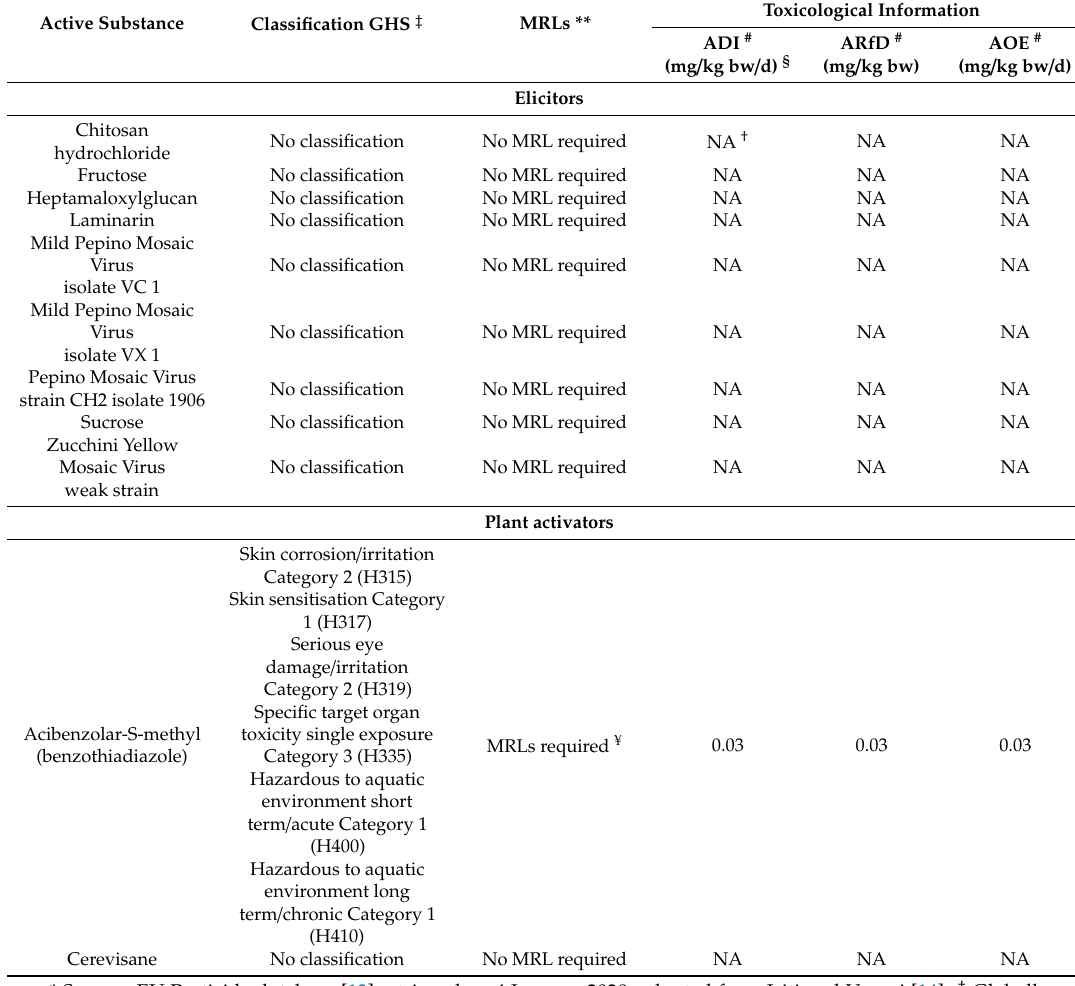
Table 2. Elicitors and plant activators approved in European Union